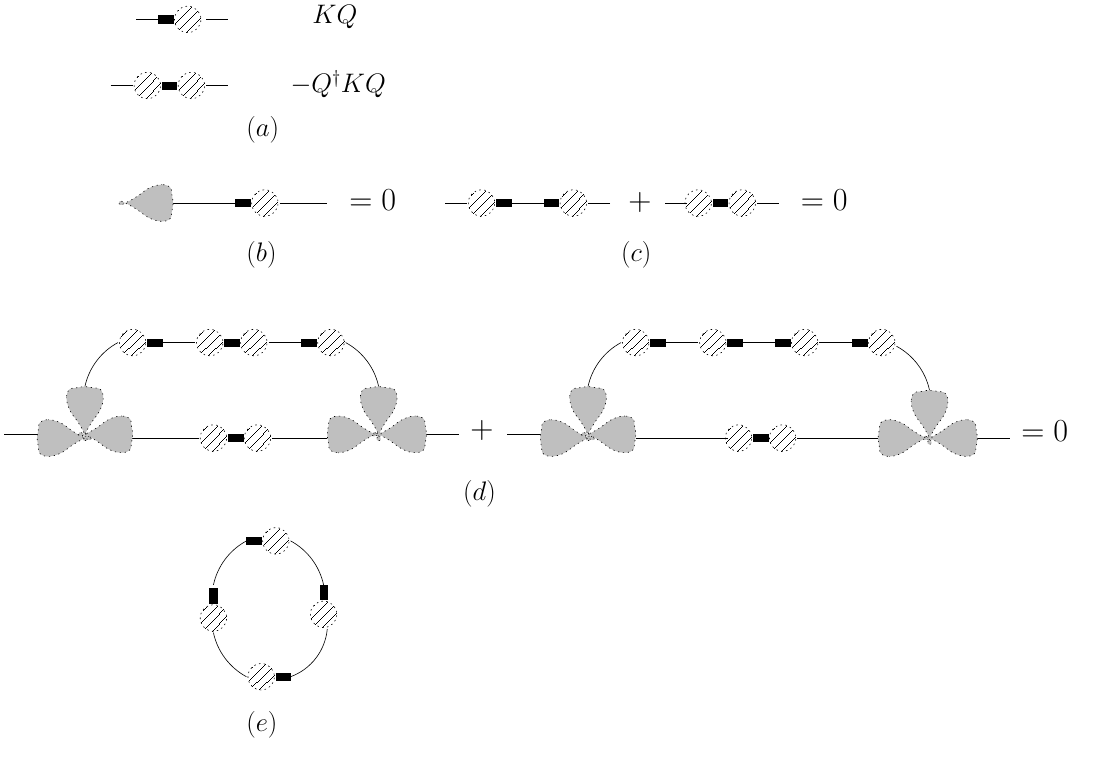
Figure 1 . (a) The two 2 -point vertices in (3.14); (b)–(c) the two basic cancelation mechanisms;